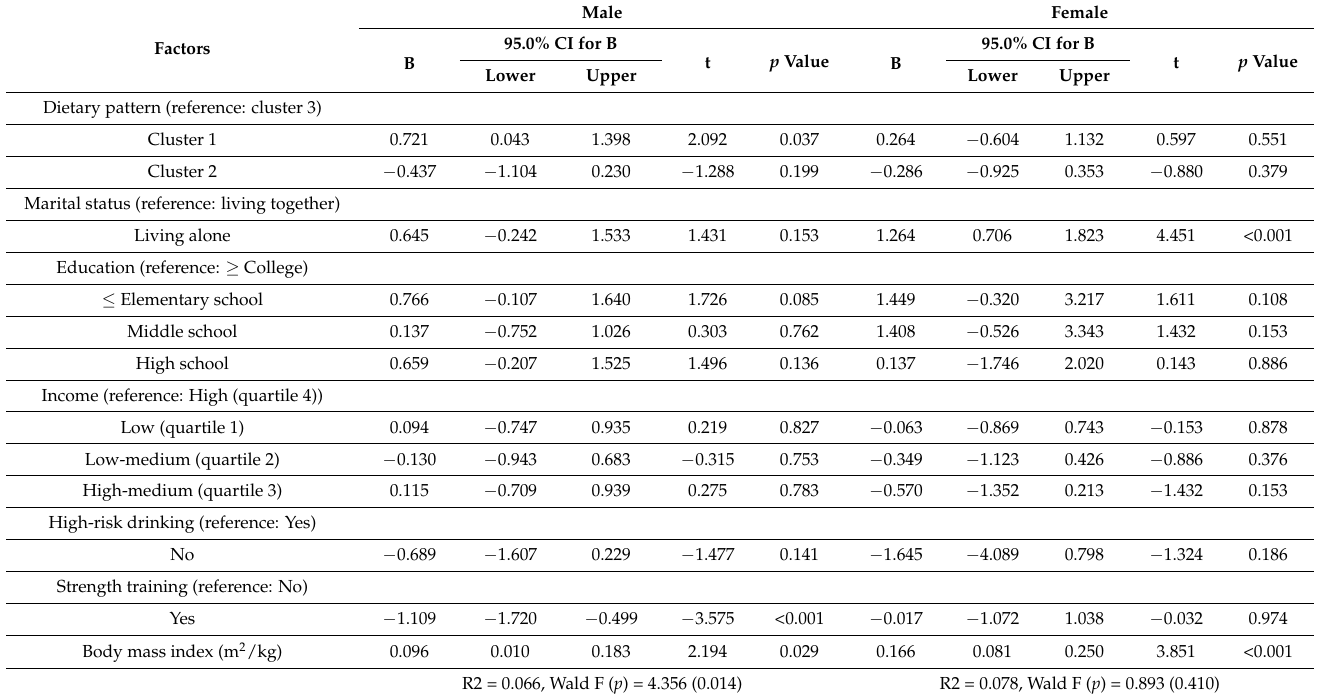
Table 3. Factors which influence total ten-year CVD